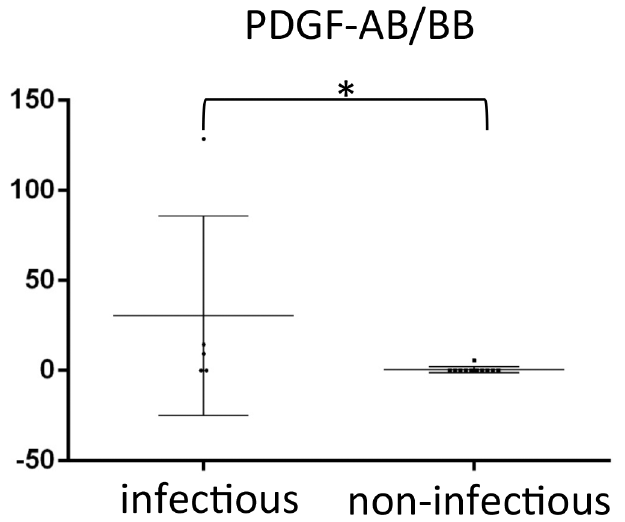
Fig 4. Comparison of levels (pg/mL) of analytes in eyes of UG cases between with infectious and non- infectious uveitis. Data points ( n = 5 for infectious and n = 11 for non-infectious) represent individual samples. Error bars represent medians ± interquartile range. * P < 0.05. PDGF, platelet-derived growth factor.